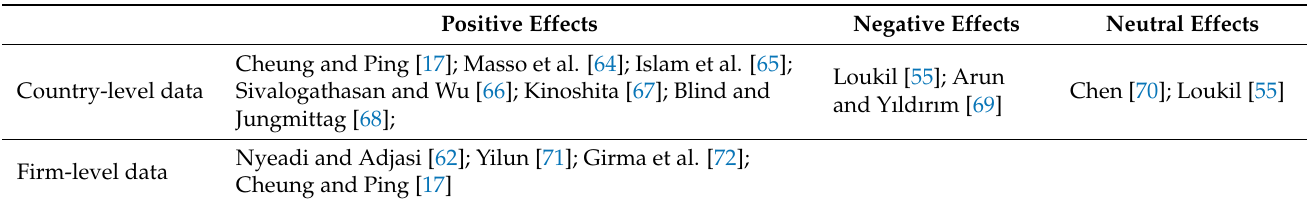
Table 1. Summary findings—nexus between international capital flows and innovation